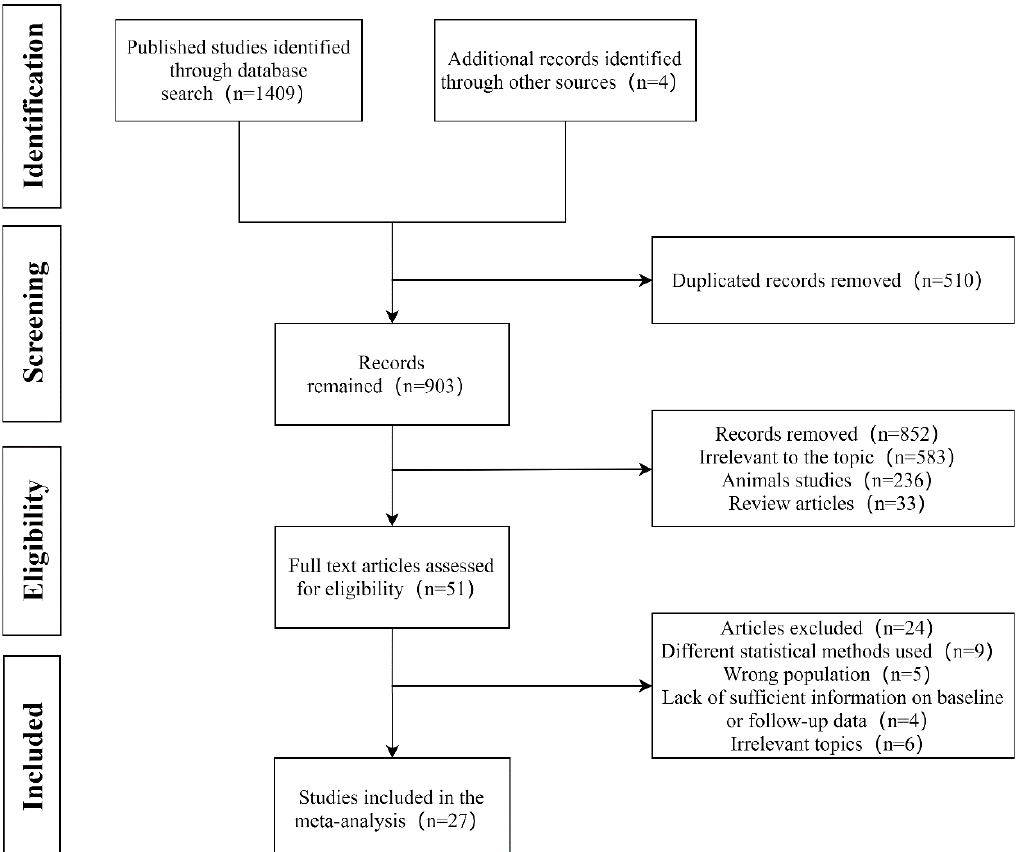
Figure 1. Flowchart of database searches and studies included in the present meta-analysis.